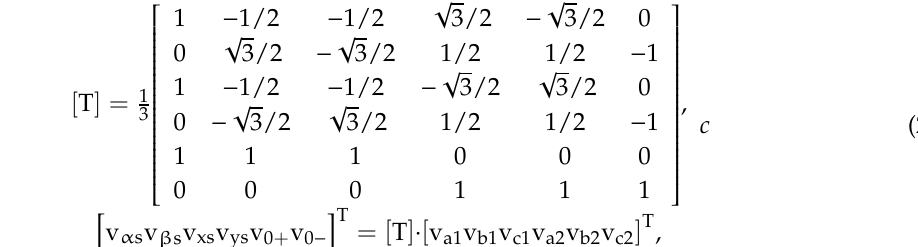
Figure 1. Asymmetrical six-phase IM ( 𝛿 = 30 ° ) drive topology.